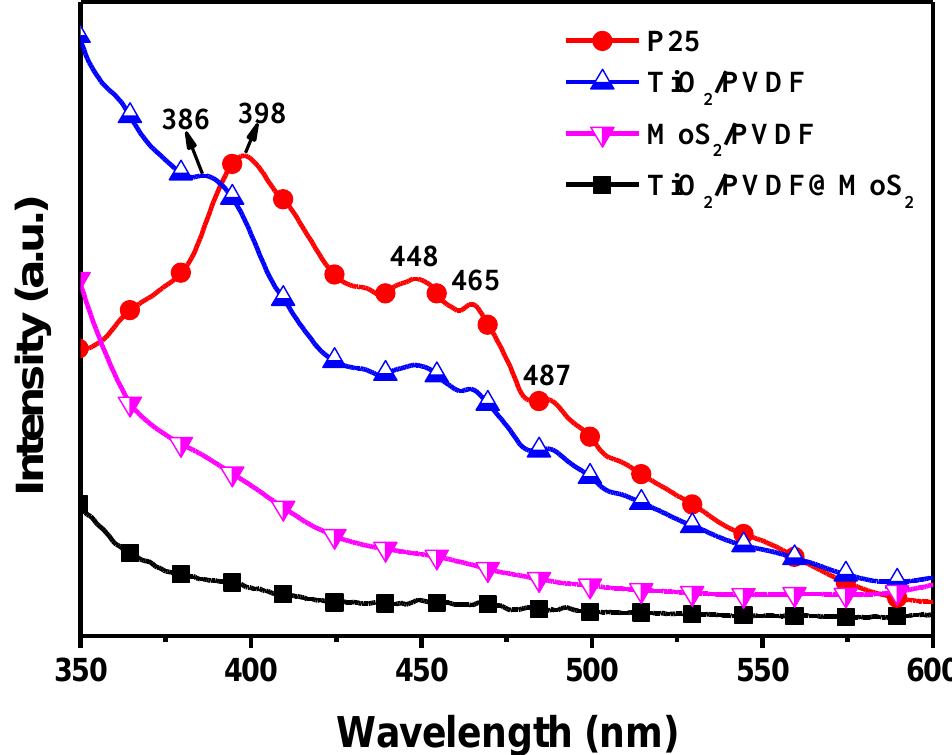
Figure 8. PL spectra of P25, TiO 2 /PVDF, MoS 2 /PVDF and TiO 2 /PVDF@MoS 2 .